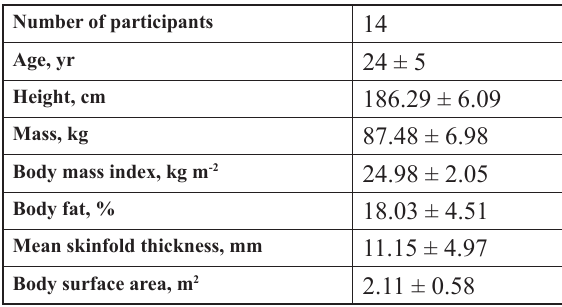
Table 1. Physical characteristics of the participants in the